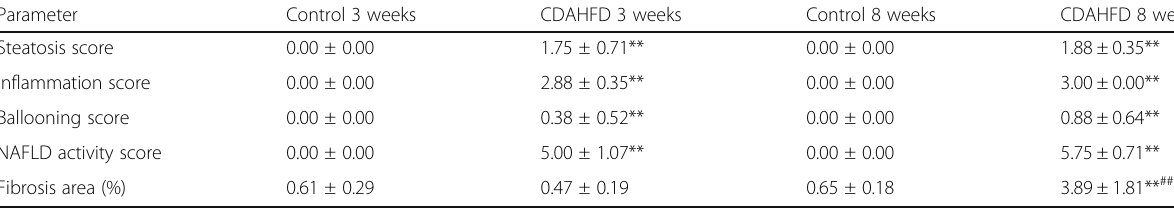
Table 2 Histological analysis of the liver in mice fed a CDAHFD